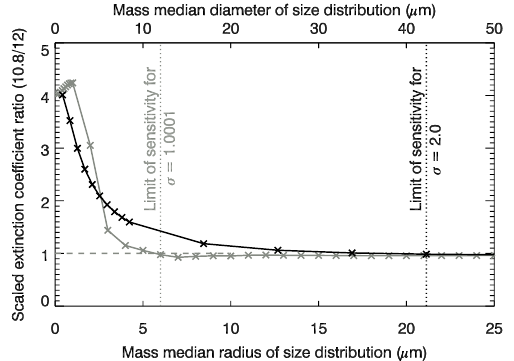
Figure 7. Scaled extinction coefficient ratio for SEVIRI channels at 10.8 and 12.0µm for spherical andesite volcanic ash particles as a function of ash particle size. The dotted line shows the grain size at which the reverse absorption technique becomes insensitive to andesite volcanic ash. It is not possible to use BTD effects to identify or automatically detect uniformly sized spherical andesite particles with radius >6µm. With a geometric standard deviation of 2.0, the BTD effect extends to mass median radius of 21µm (black line). This corresponds to an effective radius of 16.5µm, which is comparable to the findings of Wen and Rose (1994). The sensitivity decreases rapidly with increasing mass median radius, particularly below the single-particle detection limit of